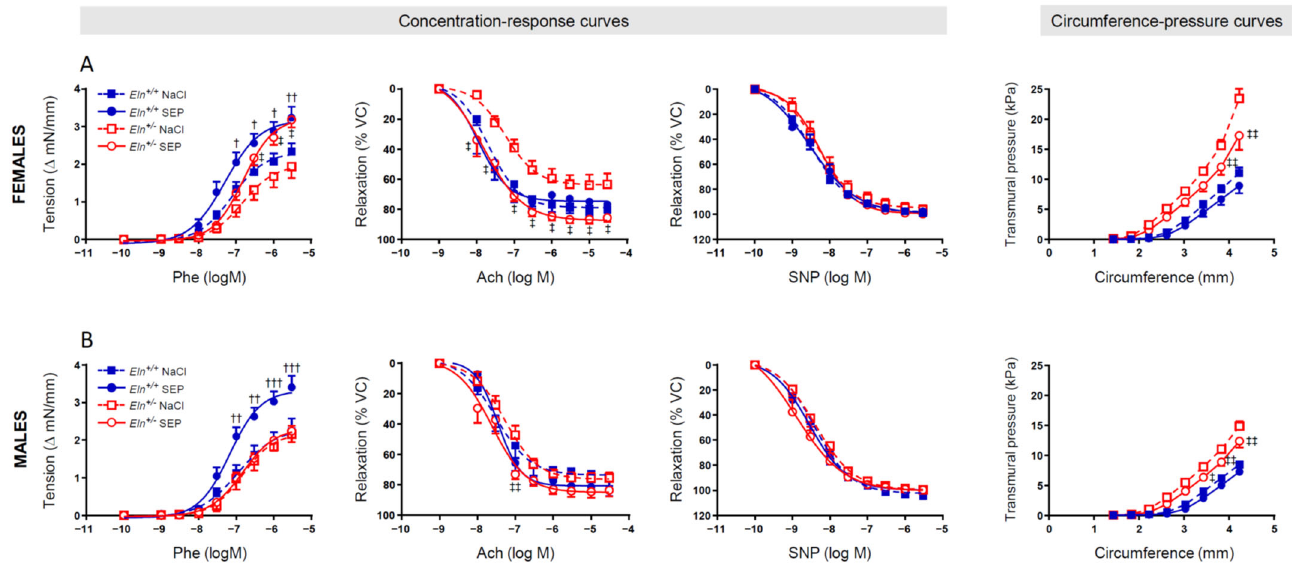
Figure 4. Concentration–response and circumference–pressure curves of the ascending aorta. The studies were performed by wire myography in aortae from female ( A ) and male ( B ) Eln +/+ and Eln +/ ‐ mice treated with a single 0.9% NaCl (controls) or synthetic elastic protein (SEP) intravenous injec ‐ tion three days before the measurements. † p < 0.05, †† p < 0.01 and ††† p < 0.001: significant differences between Eln +/+ SEP and Eln +/+ NaCl; ‡ p < 0.05 and ‡‡ p < 0.01: significant differences between Eln +/ ‐ SEP and Eln +/ ‐ NaCl (two ‐ way ANOVAs, followed, where necessary, by multiple Bonferroni post ‐ tests). Values are mean ± SEM. n = 11–14 in each NaCl group; n = 7–8 in each SEP group.